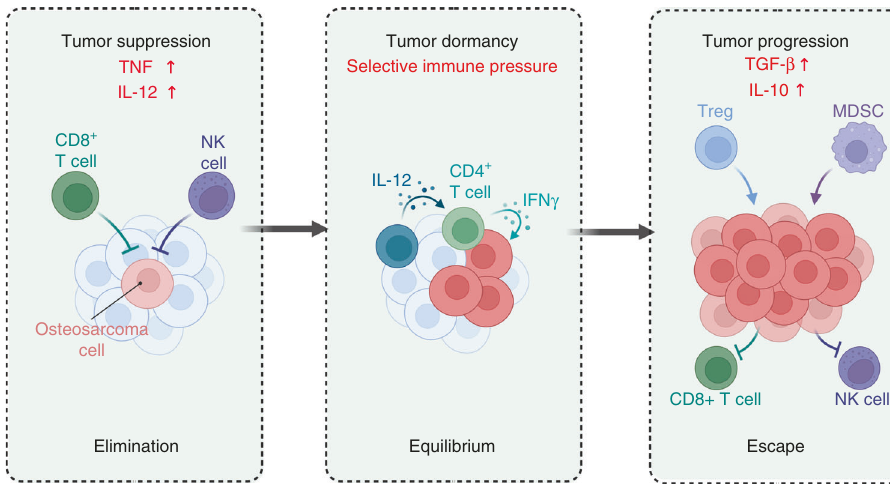
Fig. 1 The three stages of immune system attack of tumors: immune clearance, balance and